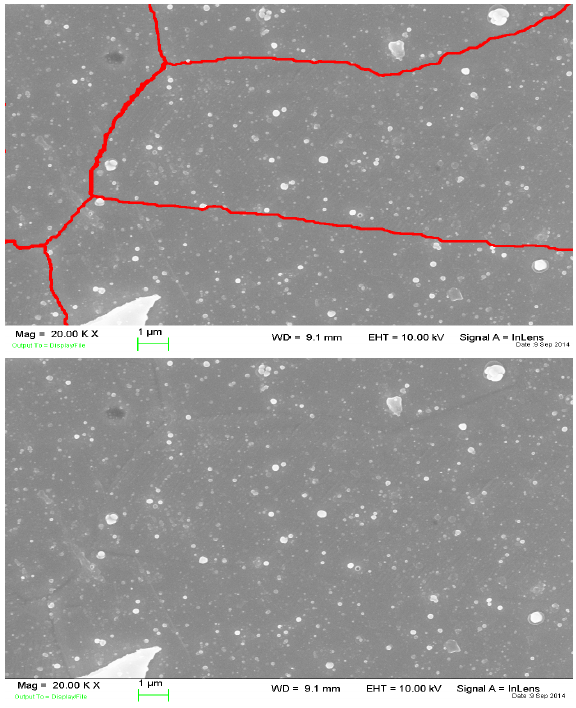
Figure 9. SEM micrograph of sample K9: TiN layer on stainless steel substrate.